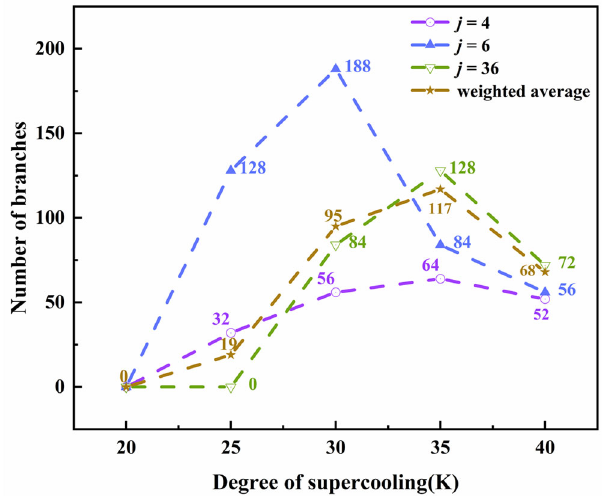
Figure 2. The relationship between the supercooling degree and the number of branches of a PTFE crystal with different anisotropic modes (evolution of time τ = 160).